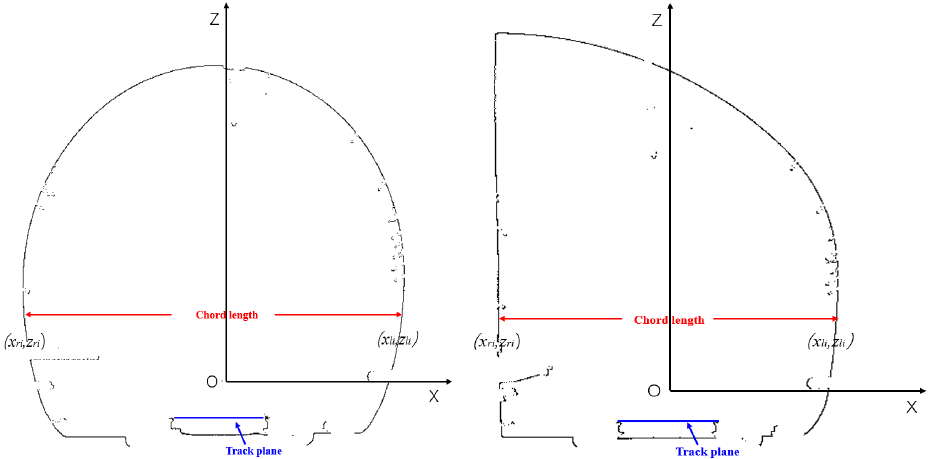
Figure 12. Chord lengths of different section types.